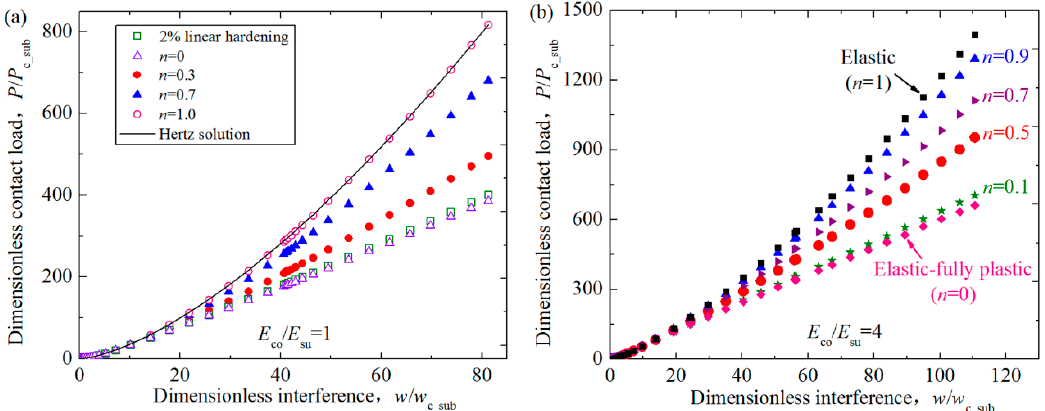
Figure 3. The relation between the dimensionless contact load P / P c_sub and interference w / w c_sub for some typical cases where dimensionless coating thickness t / R = 0.01, hardening exponents of the substrate n = 0.1, 0.5, 0.7, 0.9 and Young’s modulus ratios E co / E su = 1, 4. The results for the purely elastic ( n = 1) and elastic fully-plastic ( n = 0) cases are also given and compared with existing literature. ( a ) E co / E su = 1; ( b ) E co / E su = 4.